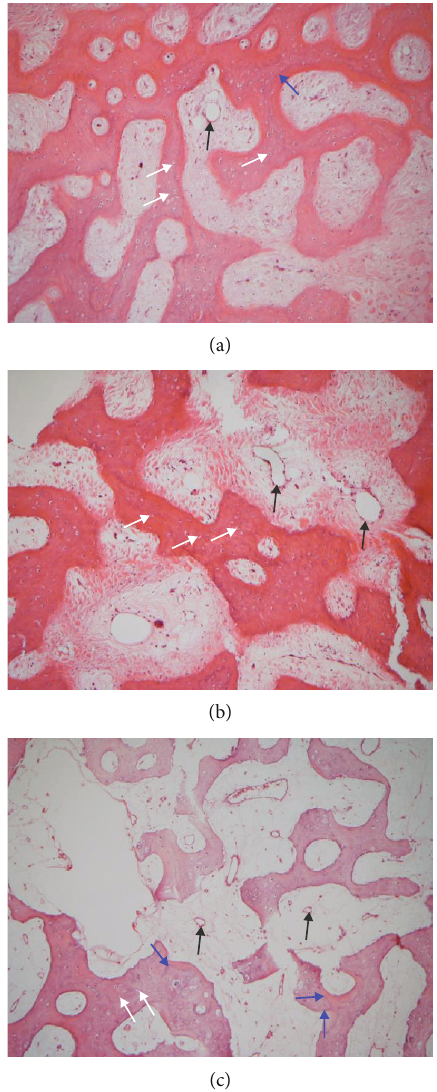
Figure 5: Models of defects C, A1, and A2 and histology. The pathological section stained with hematoxylin-eosin stain 12 weeks after reconstruction. White arrows indicate osteocytes, blue arrows indicate lamination, and black arrows indicate vessels in the marrow region. (a) The control defect C of the Tibia 2 , showing many osteocytes but seldom vessels and lamination. (b) The treatment defect A2 of the Tibia 2 , no apparent lamination formation. (c) The treatment defect A1 of the Tibia 1 , less osteocytes than defect C, but much more lamination.